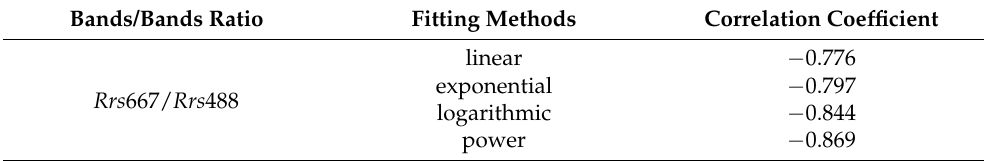
Table 3. Correlation between band ratio and in situ measured SSS based on different regressive methods.